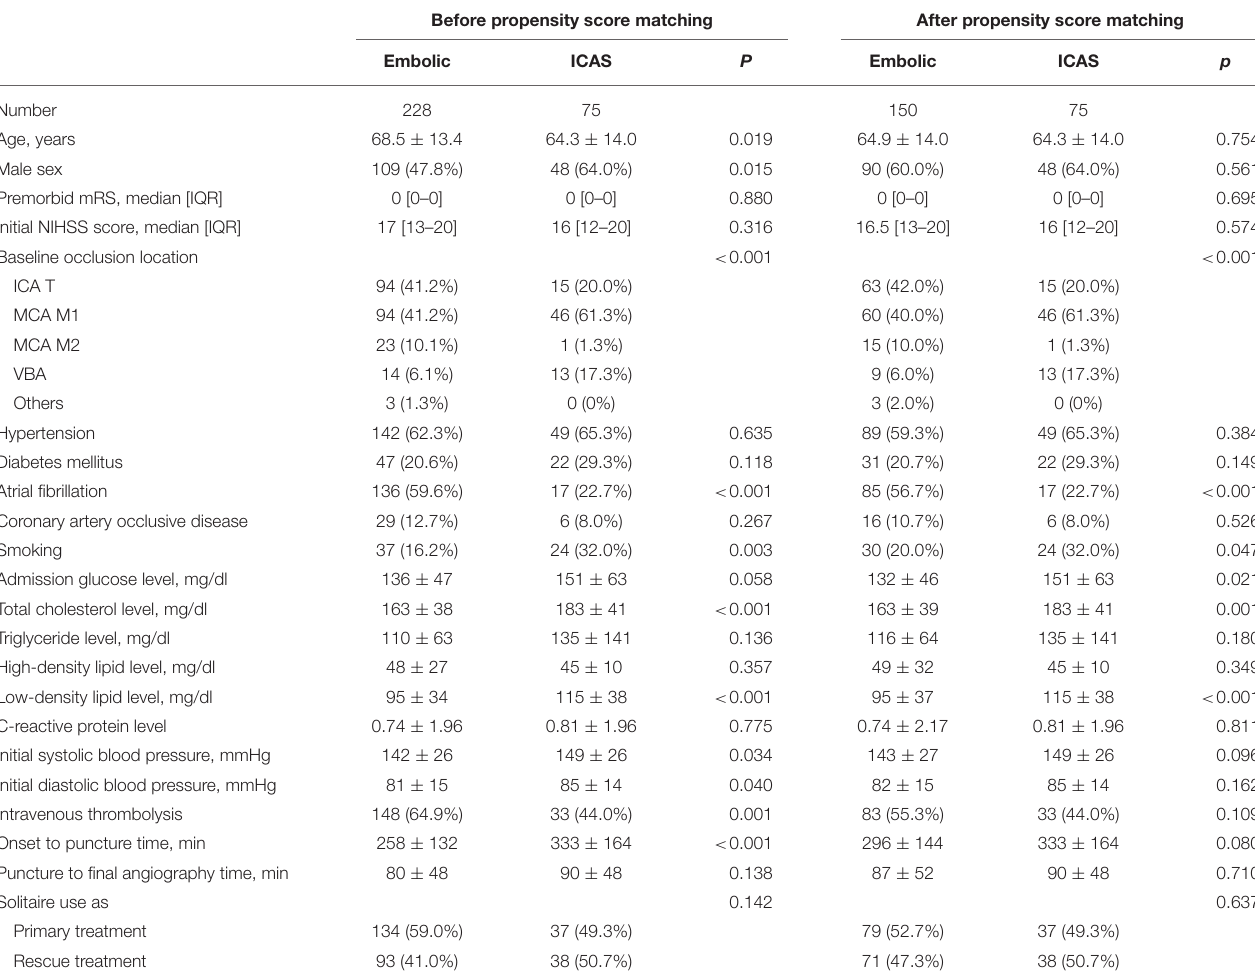
TABLE 1 | Baseline characteristics and treatments used before and after propensity score